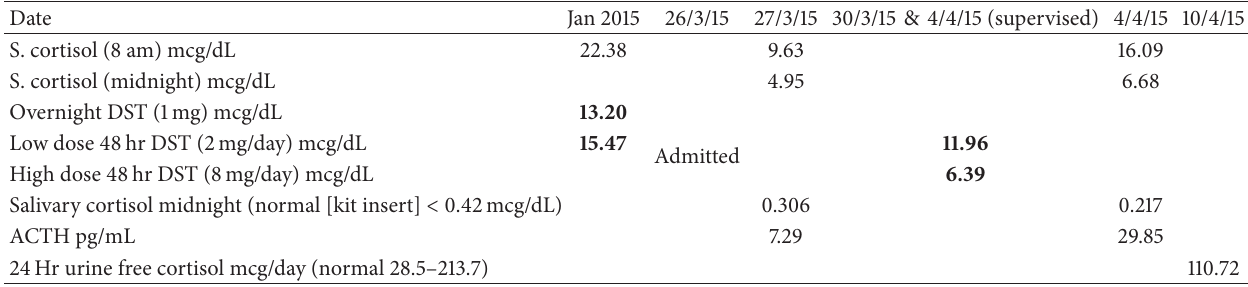
Table 2: Investigation summary-current